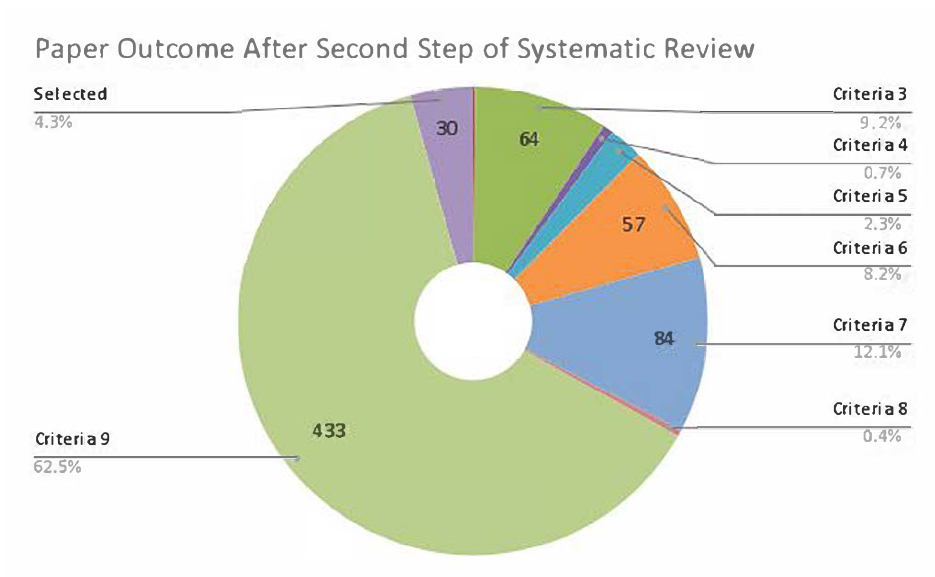
Figure 3. Division in the study outcome in selected or excluded works after the end of the second step. Excluded works are shown by exclusion criteria. Works may have more than one criterion associated with the exclusion. There are occurrences in the exclusion criteria.